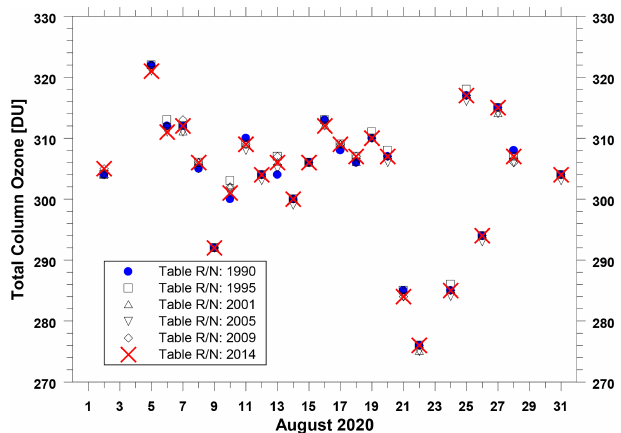
Figure 6. Daily means of TCO 3 in August 2020 from DS–AD mea- surements as calculated with different R–N tables obtained during intercomparisons in the 1990s and 2000s (see Table